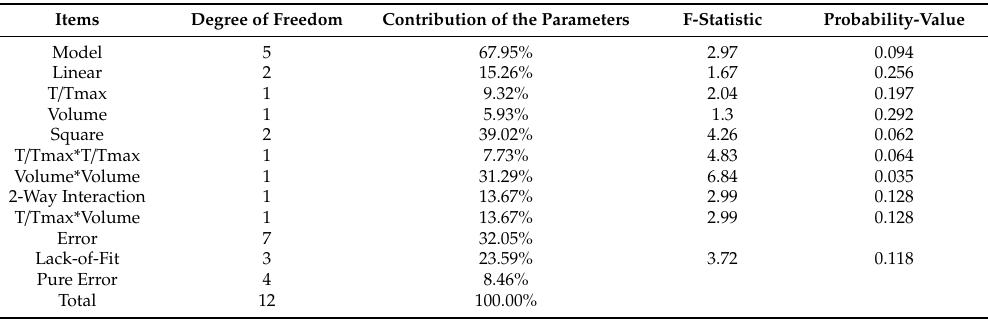
Figure 18. ( a ) Predicted viscosity, ( b ) the factorial plot and ( c ) the contour plot for the viscosity. Table 5. ANOVA table for viscosity.